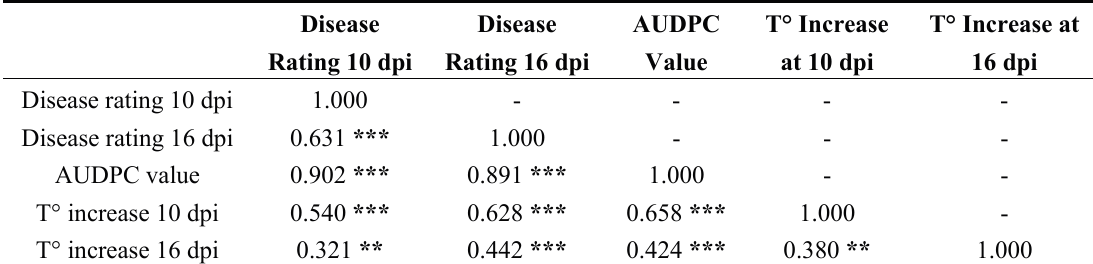
** and *** indicates the significance of the correlation coefficient according to the Student t test at 0.01 and 0.001 level respectively.